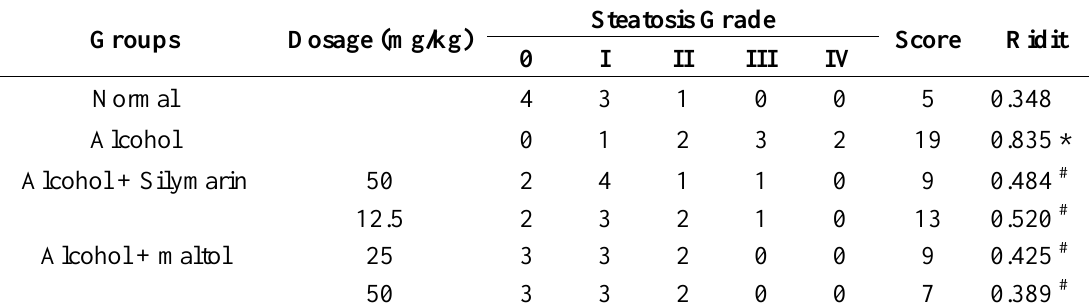
Figure 6. Photomicrographs of liver sections obtained from ( A ) Normal group, ( B ) Alcohol group, ( C ) Alcohol + Silymarin group (Silymarin, 50 mg/kg), and ( D ) Alcohol + maltol (50 mg/kg) (magnification, all 100×, Bar: 100 μm). Table 3. Score result of the pathological changes in mice